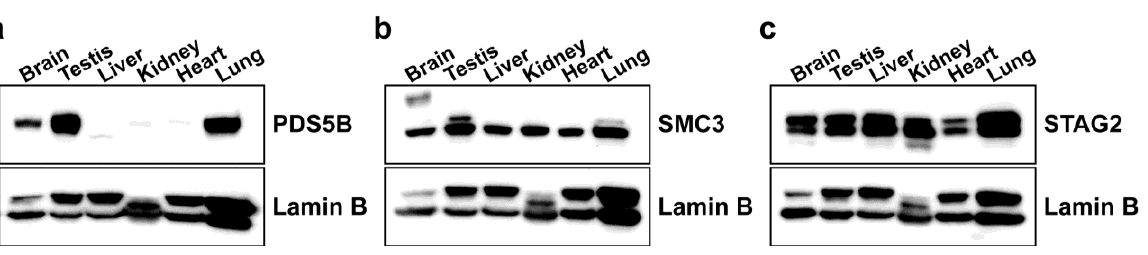
Figure 1. Expression of PDS5B and cohesin components in various mouse